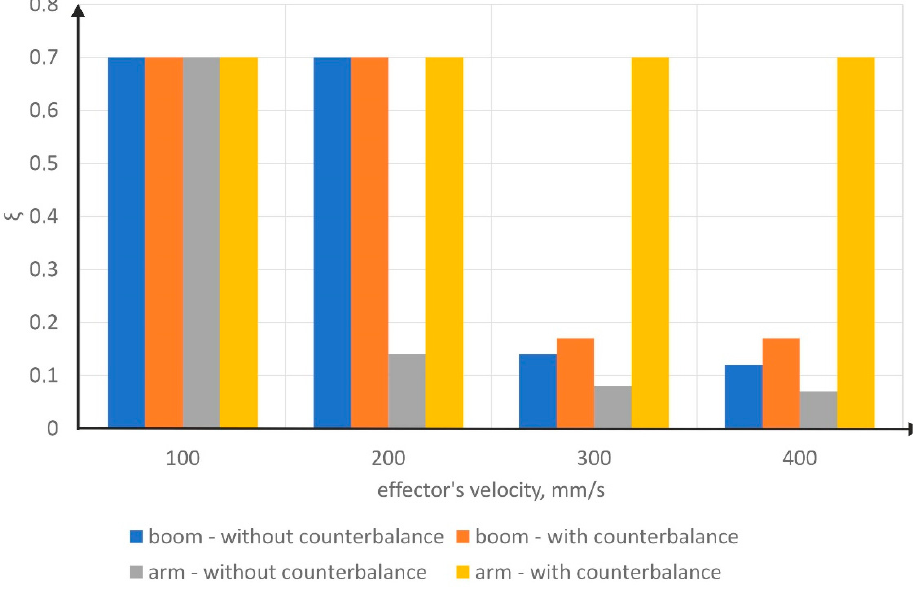
Figure 25. Damping ratio ξ , for different speeds of movement of the effector. Table 4. Frequency of pressure f for different speeds of movement of the effector.